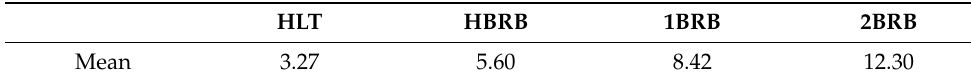
Figure 17. Boxplot of the calculated energy data. Table 5. Mean energy value of the first five test.